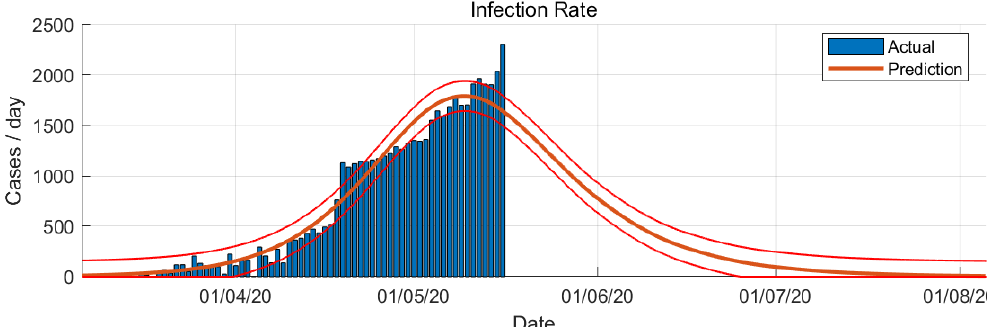
Figure 6. COVID-19 epidemic in Saudi Arabia prediction based on SIR model (infection